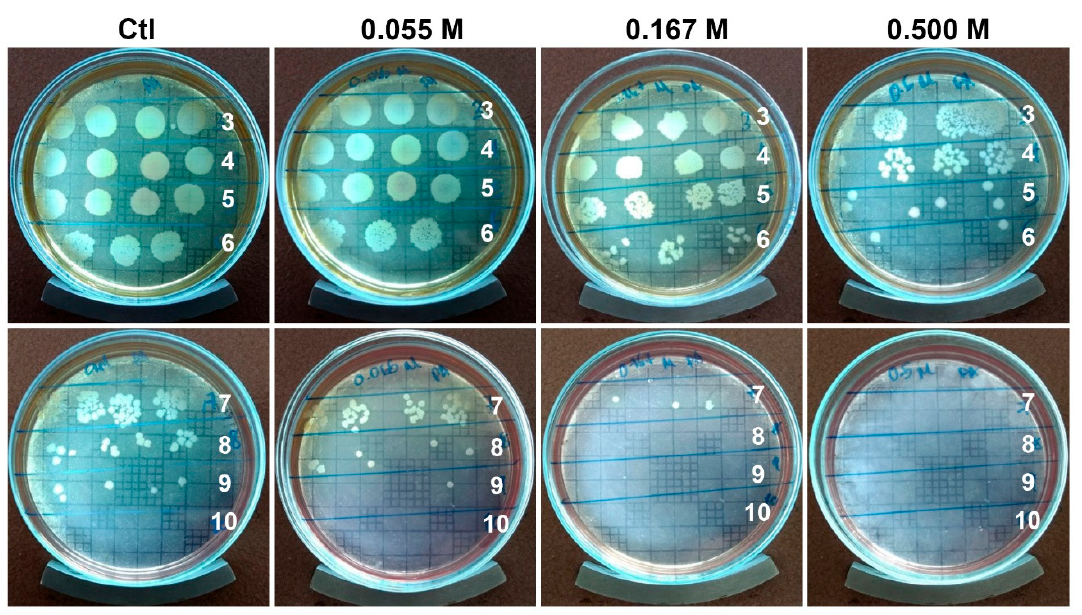
Figure 6. Radiosterilized porcine skin electrosprayed with silver nanoparticles reduces the number of CFU of Pseudomonas aeruginosa . Numbers indicate absolute serial dilutions. Ctl, control. The results show that the clinical strain was susceptible to the treatments, with a CFU